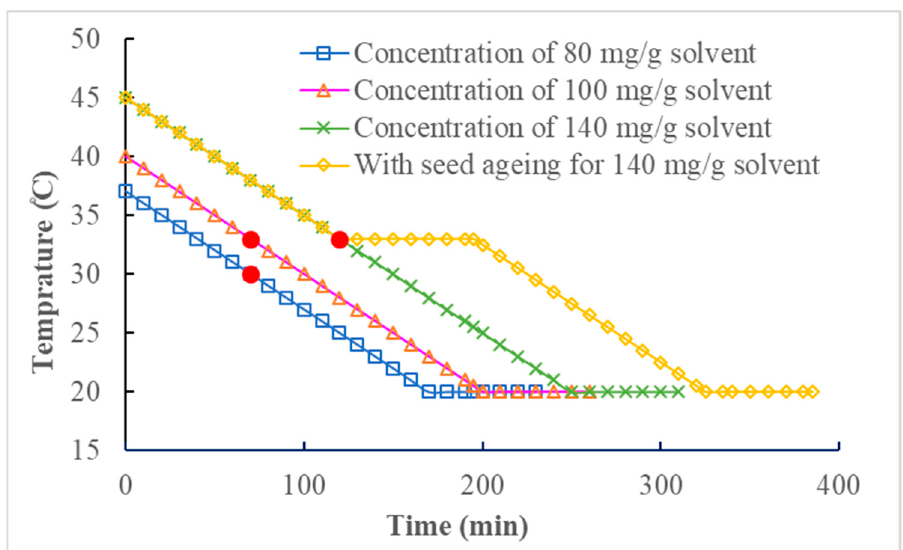
Figure 5. Cooling profiles for seeded crystallization experiments with different starting ibuprofen concentrations (Experiments 4–7). Cooling rate set at 0.1 °C/min. Seeding points were marked by filled red circles. The two red circles for Experiments 6 and 7 overlapped.